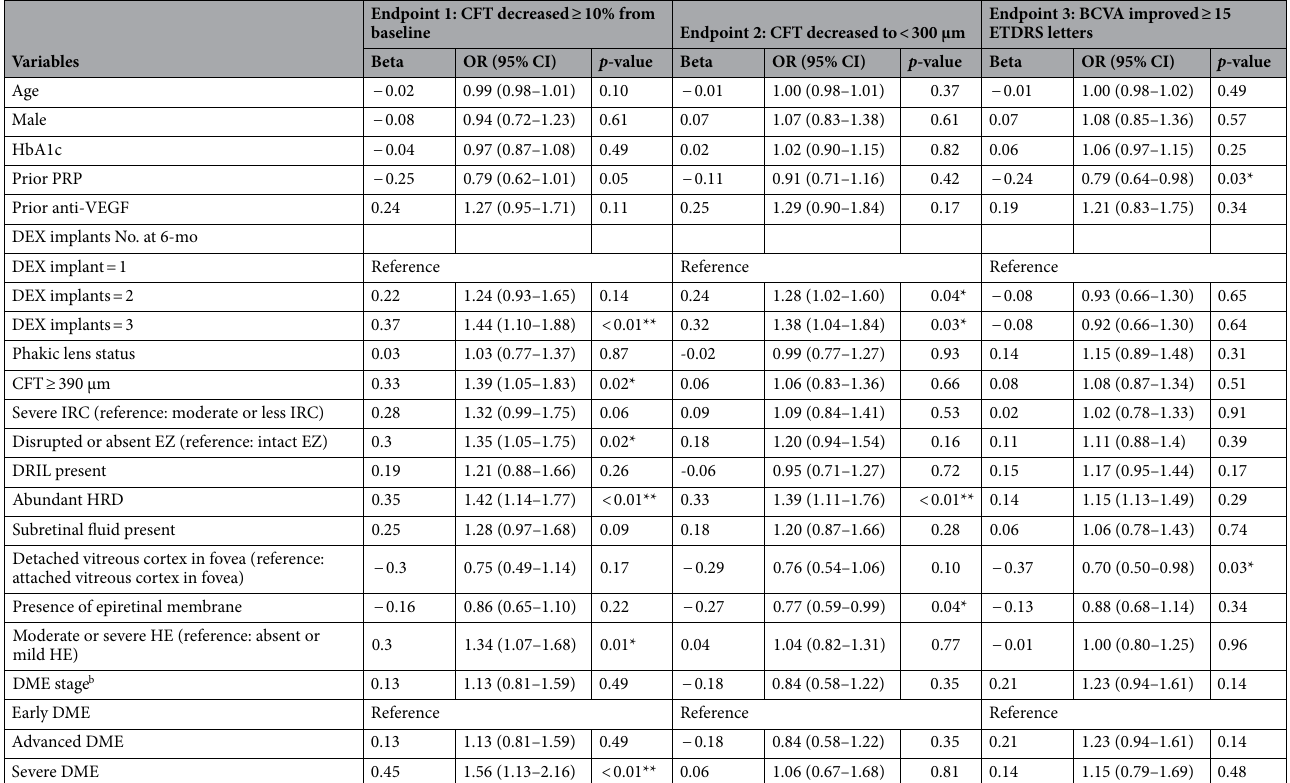
Table 4. Univariate analysis for predictors of 6-month outcomes in diabetic macular edema treatment with DEX implants a . * P < 0.05; ** P < 0.01. a Univariate logistic regression analysis. b DME stage was graded according to a previous study 20 . Abbreviation: anti-VEGF anti-vascular endothelial growth factor, BCVA best-corrected visual acuity, CFT central foveal thickness, DEX implant dexamethasone intravitreal implant, DME diabetic macular edema, DRIL disorganized retinal inner layers, ETDRS Early Treatment Diabetic Retinopathy Study, EZ ellipsoid zone, HE hard exudates, HRD Hyperreflective dot, IRC intraretinal cyst, PRP = panretinal